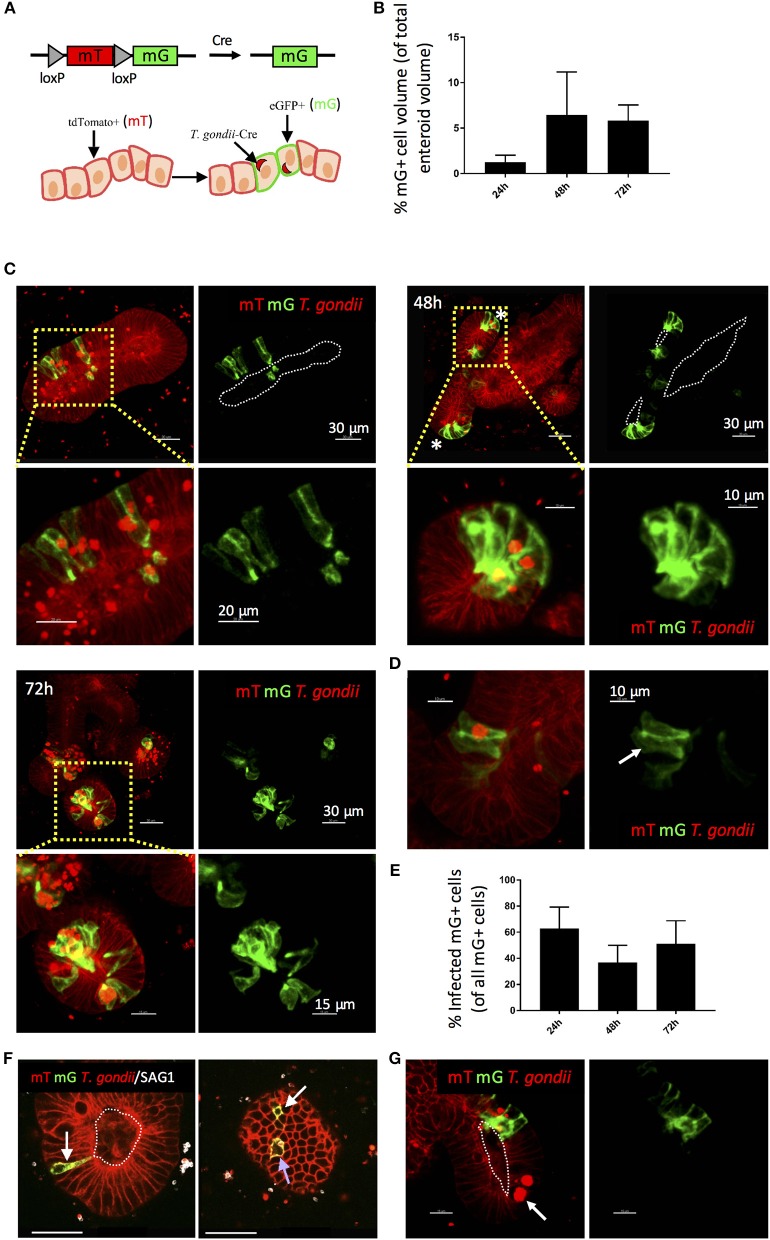
Use of a Cre-secreting parasite confirms Invasion of enteroid epithelial cells by T. gondii. ROSAmT/mG enteroids were infected with 1 × 107
T. gondii Pru-tdTom-Cre/well and incubated for 24–72 h before confocal imaging. (A) Enteroid epithelial cells from ROSAmT/mG mice express membrane tdTomato (mT), and upon exposure to Cre-recombinase, the tdTomato gene is cleaved and membrane eGFP (mG) is expressed in its place. Pru-tdTom-cre parasites secrete cre into the host cell upon invasion. T. gondii infected epithelial cells should therefore express mG. (B) Graph depicts volume of mG-expressing epithelial cells as a percentage of enteroid volume. Data are pooled from two independent experiments (for each experiment, one data point representing the mean of two wells per condition, and three images captured per well, is plotted). Mean ± SEM is shown. (C) 20 μm orthoslices (or maximum intensity projections for insets) of z-stack images showing ROSAmT/mG enteroids infected with T. gondii Pru-tdTom-Cre over a 72 h period. Parasite tdTomato signal (red) is distinguished from host tdTomato signal (mT; red) by morphology and fluorescence intensity. Parasites appear as bright puncta. Infected cells also express membrane eGFP (mG; green). *Indicates crypt base. (D) An epithelial cell expressing mG, but not containing a parasite is indicated with a white arrow. (E) Graph depicts the proportion of infected (parasite-containing) mG+ cells among total mG+ cells. Data are pooled from two independent experiments (for each experiment, one data point representing the mean of two wells per condition, and three images captured per well, is plotted). Mean ± SEM is shown. (F) An infected (parasite-containing) epithelial cell expressing mG is indicated with a blue arrow, and distant uninfected Cre-exposed mG+ cells (D-U mG+) are indicated with white arrows. (G) An epithelial cell containing replicating parasites, but not expressing mG, is indicated with a white arrow. White dotted lines indicate apical surfaces of the epithelium throughout.